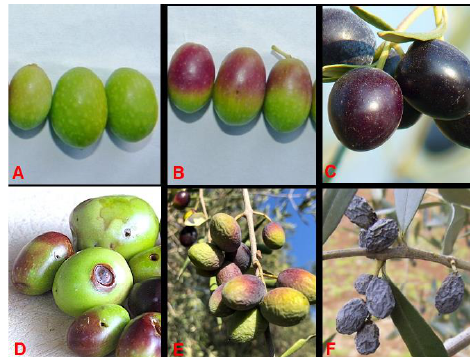
Figure 1. ( A ) “Top Green ; ” ( B ) “Good Green ; ” ( C ) “Good Black ; ” ( D – E ) “Bad Green ; ” ( F ) “Bad Black”.